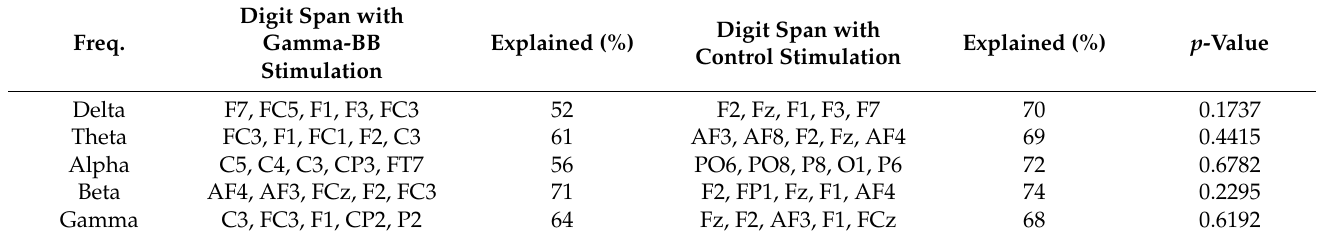
Table 3. The five channels contributed most to the PCA first component, total variance explained by the first component and p -values for permutation test results for experimental and control stimulation during the digit span task.